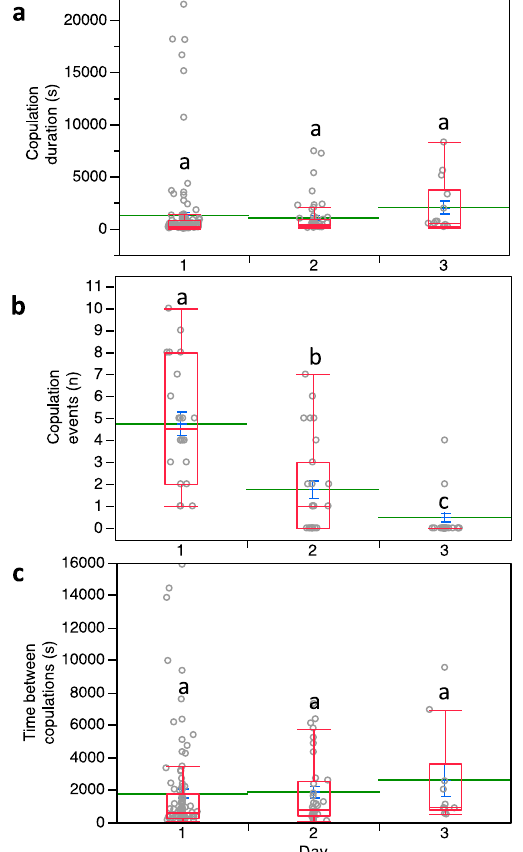
Figure 1. ( a ) Copulation duration, ( b ) number of copulation events and ( c ) time between copulations in Pseudococcus calceolariae . Box plots indicate the median (line) within each box and the range of dispersion (lower and upper quartiles and outliers). Green lines and blue T-bars indicate means and standard errors, respectively. Above each box plot, different letters indicate significant differences (general linear mixed model (GLMM), Tukey’s HSD test, p < 0.05). After the first day of mating, 56.7% of males survived and were then able to mate on the second day; 20% survived the second day and then mated during the third day. Just one male survived the third day and mated on the fourth day (Figure 2).